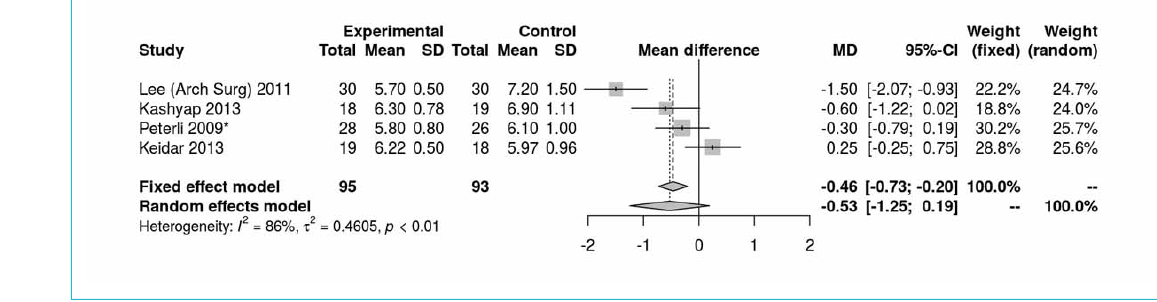
Figure 7e: Body mass index (BMI) at 12 months (analysis of studies including only patients with type 2